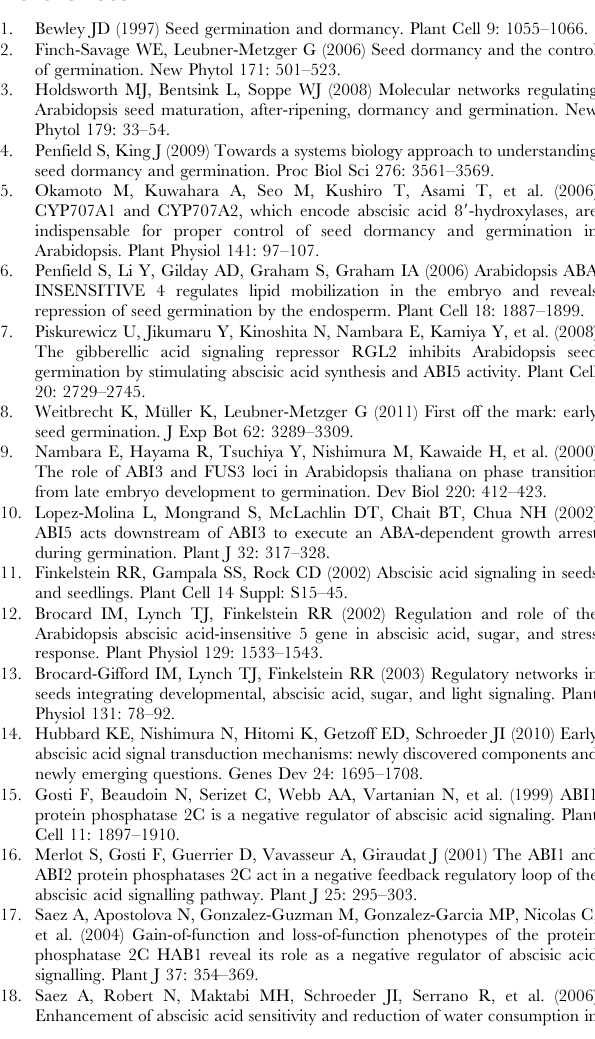
Figure S1 Comparisons of the germination time courses of wild type (WT) control, four single mutants ( hrs1-1 , abi3-8 , abi4-1 and abi5-7 ), and three double mutants ( hrs1-1abi3-8 , hrs1-1abi4-1 and hrs1-1abi5-7 ) on 1/2 MS medium. The percentages of radicle emergence (means 6 SD, each calculated using the results from triplicate samples) of the eight genotypes were recorded daily for six days. The dataset displayed is typical of four independent germination assays. Figure S2 Comparisons of the deduced amino acid sequences of HRS1 and its sequence homologs in Populus trichocarpa (XP_002311443), Ricinus communis (XP_002529155), Vitis vinifera (XP_002281762), Zea mays (NP_001136626), Sorghum bicolor (XP_002441840), and Oryza sativa ssp. japonica (NP_001046702, encoded by Os02g0325600 ). The sequence homologs of HRS1 were found in many plant species by BLASTP search in the NCBI